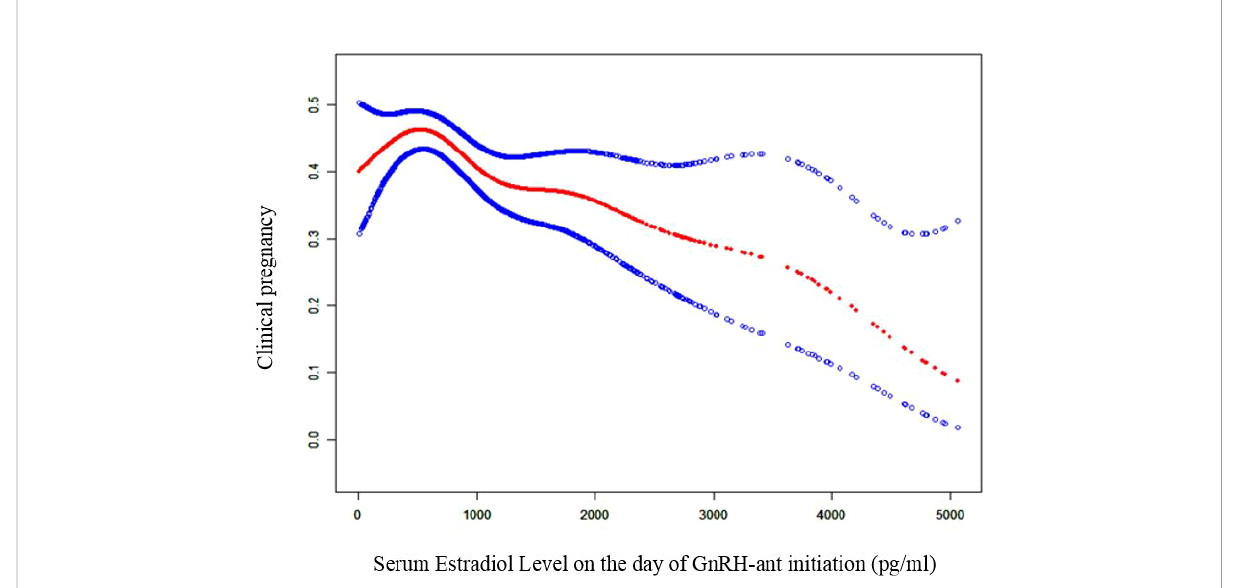
FIGURE 2 Curve fi tting diagram of serum estradiol level on GnRH-ant start day and clinical pregnancy. Age, infertility duration, body mass index, cycle number, AFC, and the number of transferred embryos were used as adjusted variables when analyzing the relationship between serum estradiol level on the day of GnRH-ant initiation and clinical pregnancy. GnRH-ant, gonadotropin releasing hormone antagonist.